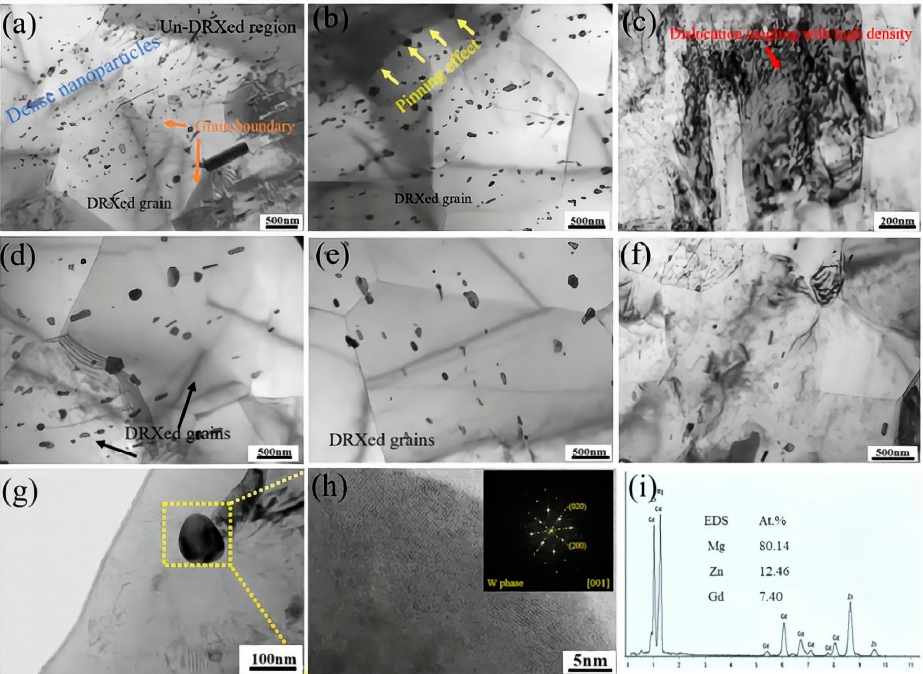
Figure 5. Schematic images of TEM bright–field (BF): ( a , b ) DRXed and un–DRXed regions in E320, ( c ) E320, ( d , e ) E360, ( f ) E400, ( g ) spherical nanoscale phase, ( h , i ) HRTEM micrograph, FFT image and EDS result corresponding to the nanoscale precipitate in ( g ) [81]. Reprinted with permission from ref. [81]. Copyright 2022 Elsevier.